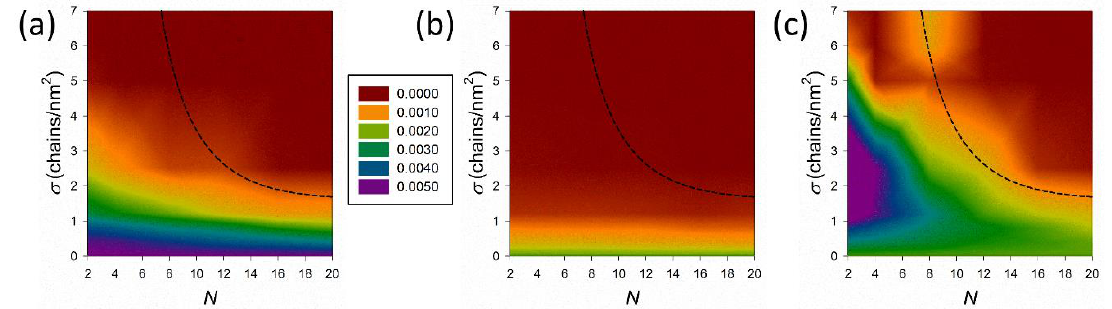
Figure 6. 2D density maps of ( a ) water, ( b ) Na + , and ( c ) Cl − obtained close to the PEG / PEI surface and displayed by color-scale in N – σ plane. Black dashed line indicates the brush transition from mushroom to SDPB regime.